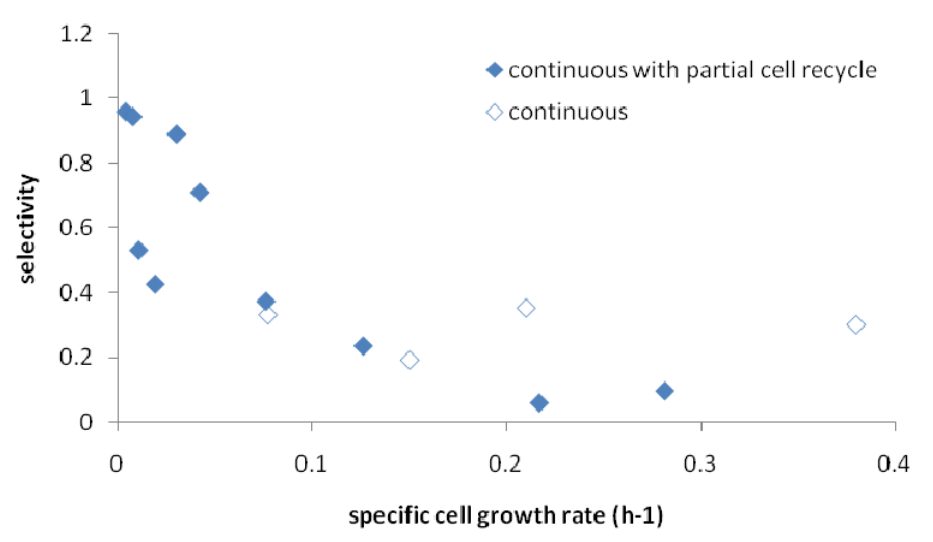
Figure 3. Influence of specific cell growth rate to selectivity of butyric acid in continuous fermentation by C. tyrobutyricum at pH of